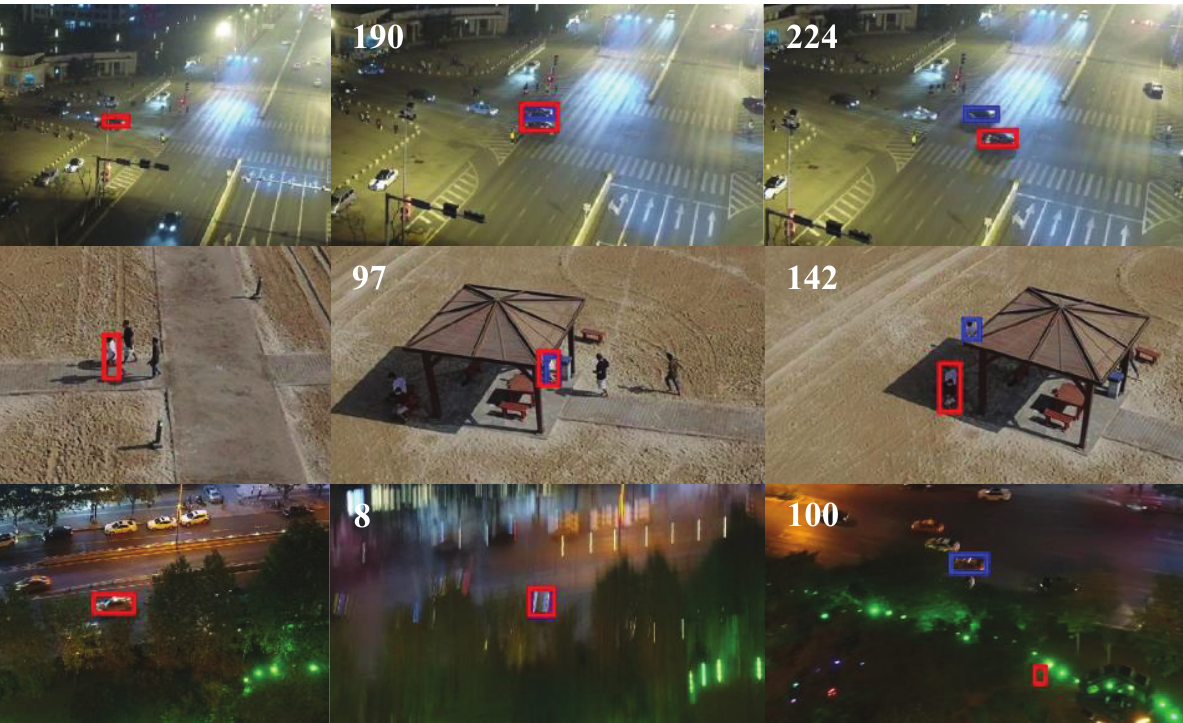
Figure 15. Failure cases in UAVDT and